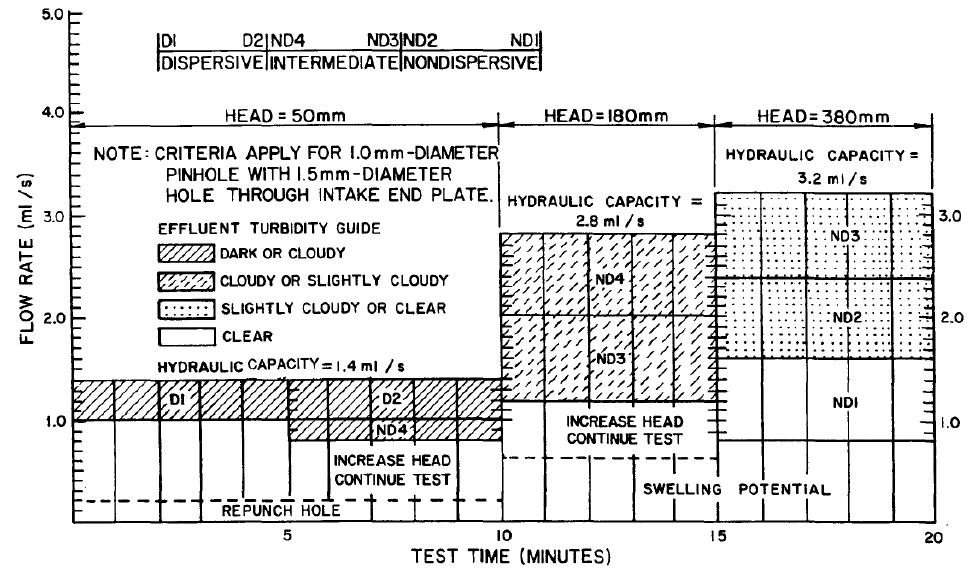
Figure 8. The pinhole test ‐ based dispersion classification for clayey soils [33].